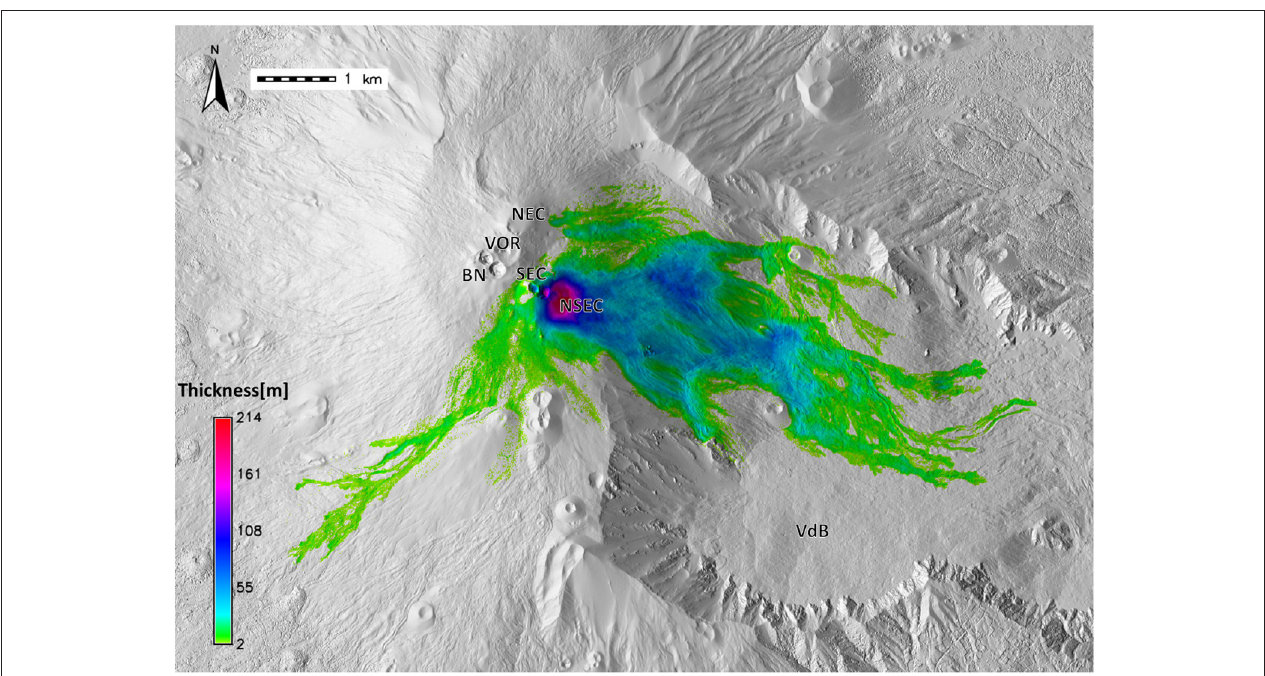
FIGURE 8 | Topographic changes due to the volcanic deposits emplaced during the eruptive activity of Etna occurred between 2006 and 2015. The colors indicate flow thickness. The total area covered is ∼ 12.6 × 10 6 m 2 ; the maximum thickness of 214m is obtained in correspondence of the NSEC cone. The base map is the shaded relief of the 2005 DEM. NEC, North-East Crater; VOR, Voragine; BN, Bocca Nuova; SEC, South-East Crater; NSEC, New South-East Crater; VdB, Valle del Bove.